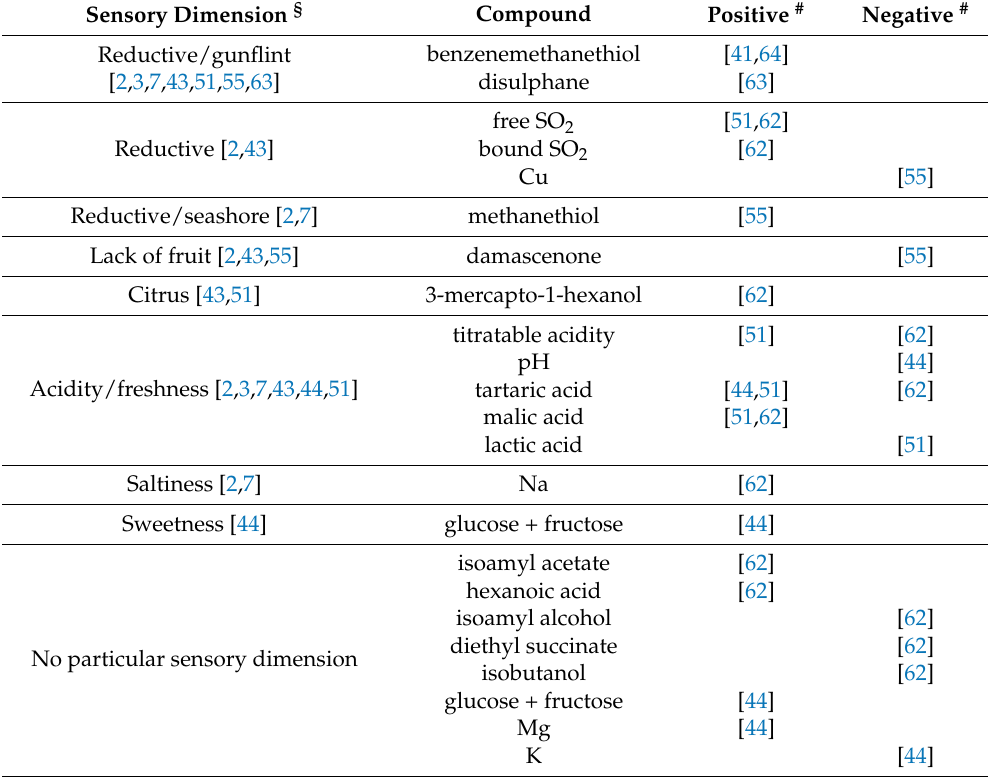
Table 1. Summary of the chemical compounds having a significant positive or negative impact on perceived minerality. § in brackets, the numbers of the references where the sensory dimension has associated significantly with perceived minerality. # in brackets, the numbers of the references where the chemical compound has associated significantly with perceived